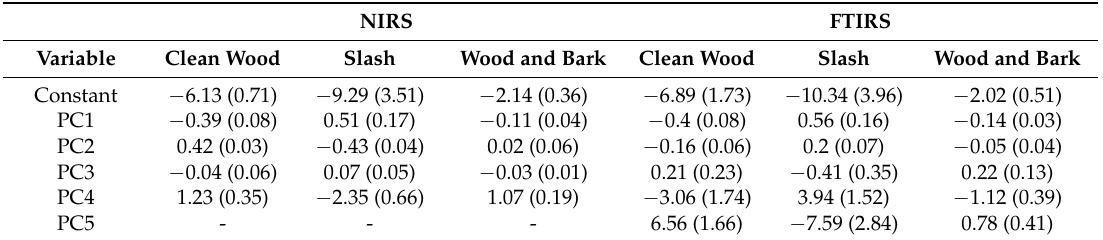
Table 2. Linear discriminant functions used for classifying plant part components.